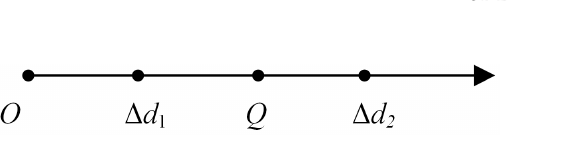
Figure 6. 1-D extension set of car-following distance